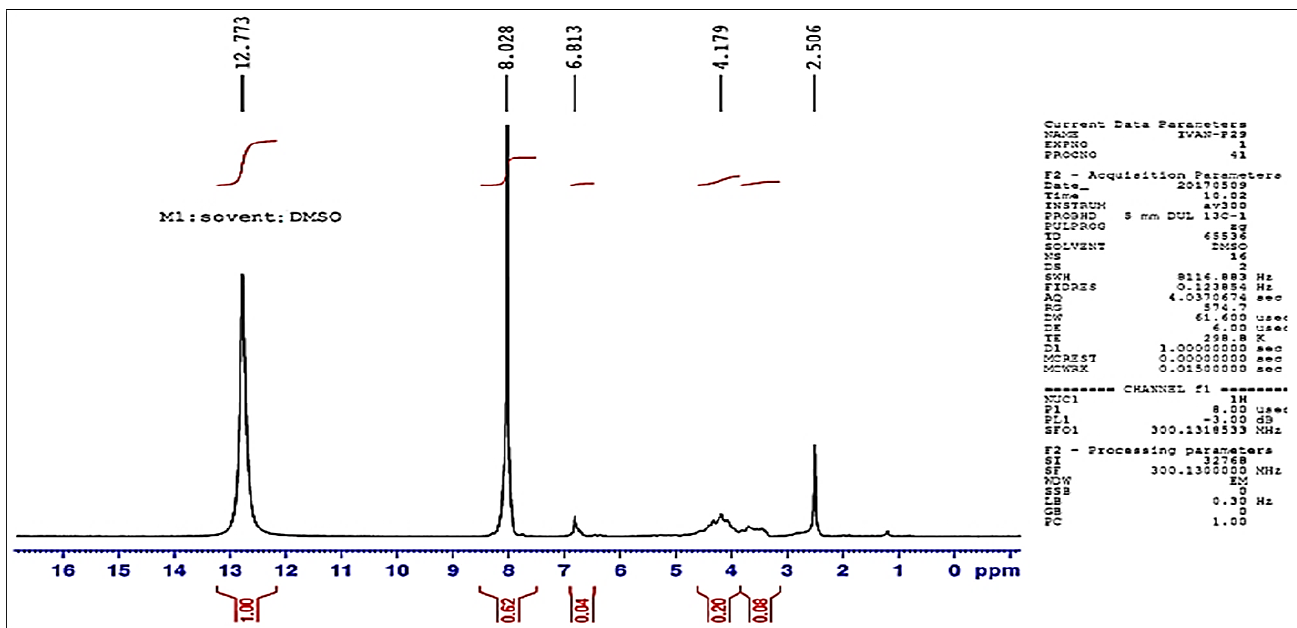
Figure 4. 1 H-NMR spectra of the prepared poly (terephthalic- co -glycerol- g -fumaric acid) nanoparticles.